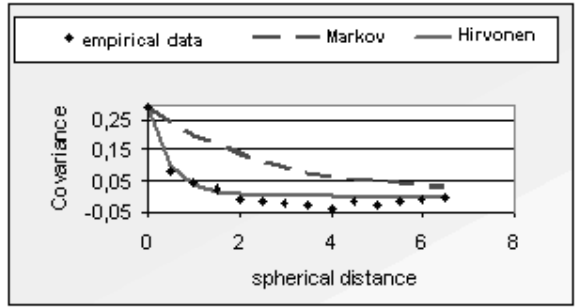
Fig 7. Diagram of the empirical covariance function calculated on the basis of nodal bench marks